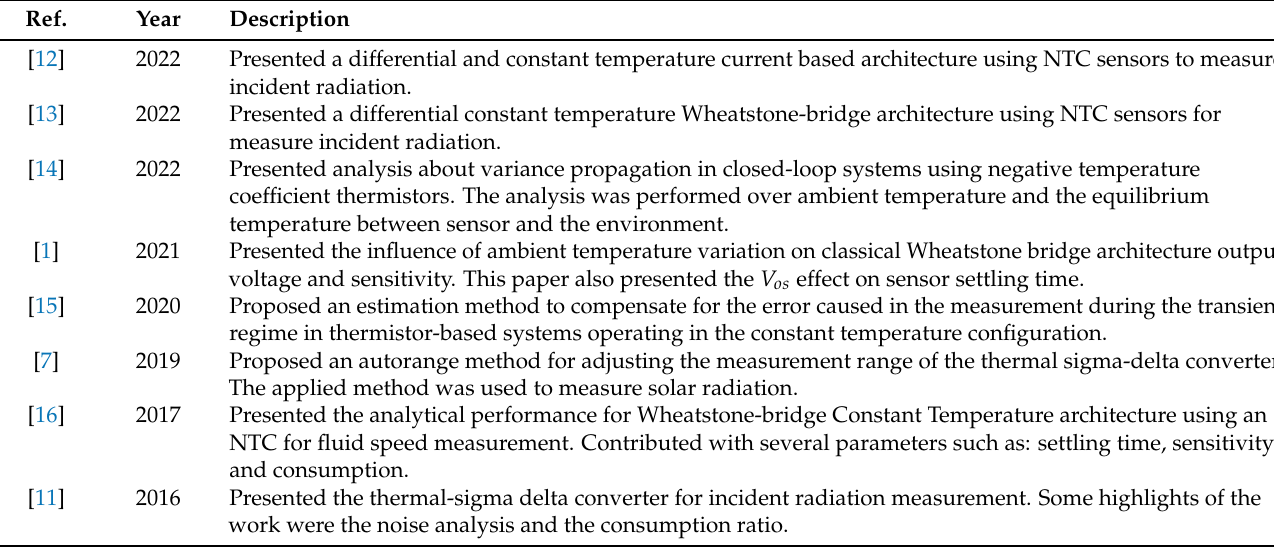
Table 1. State of the Art summarized in the last 6